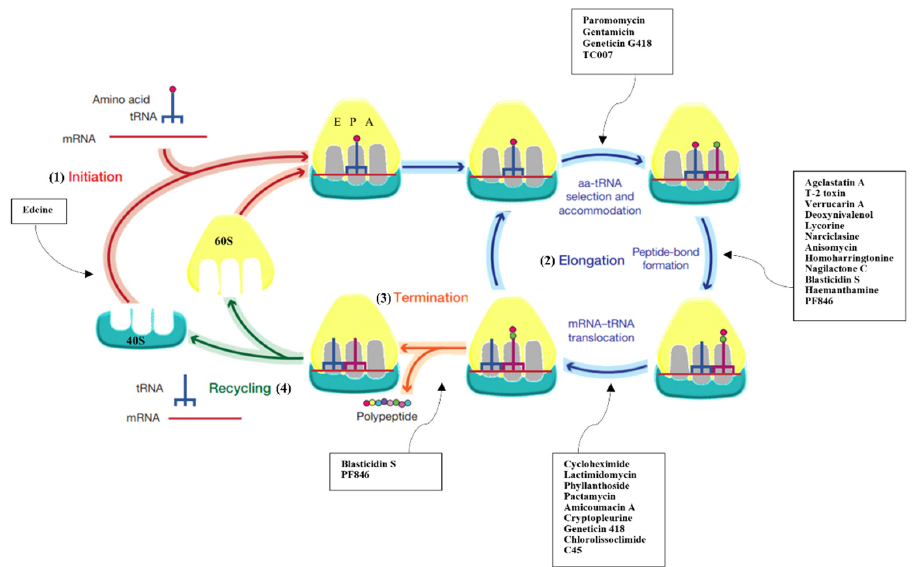
Figure 1. Protein synthesis inhibitors target several steps of translation. Scheme reporting the different phases of protein synthesis: (1) initiation, where initiator tRNA (tRNAi) binds to the 40S subunit upon start AUG codon recognition; (2) elongation, where peptide bond formation occurs upon selection of the correct cognate tRNA; (3) termination, which triggers the nascent chain’s release upon encountering the stop codon; (4) recycling, where 80S splits up to deliver individual subunits back into the cycle. Overview of the pathways that are inhibited upon binding of small molecule drugs presented in this